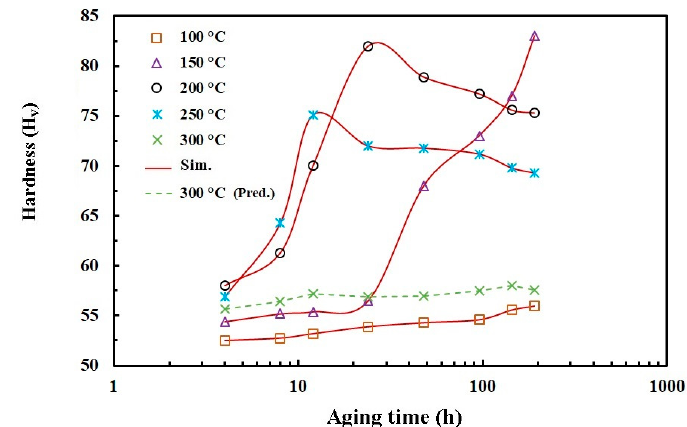
Figure 10. The ANN performance for hardness profile of AZ91 alloy.